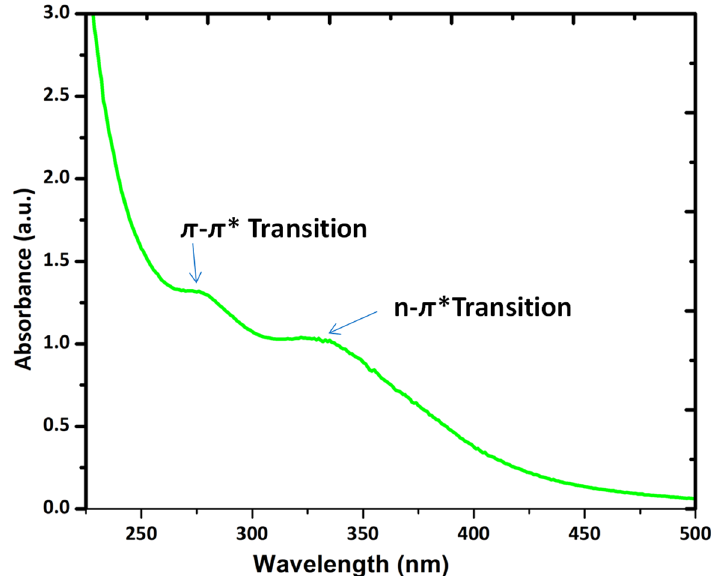
Figure 4. The UV-visible absorption spectrum of fluorescent CQDs.